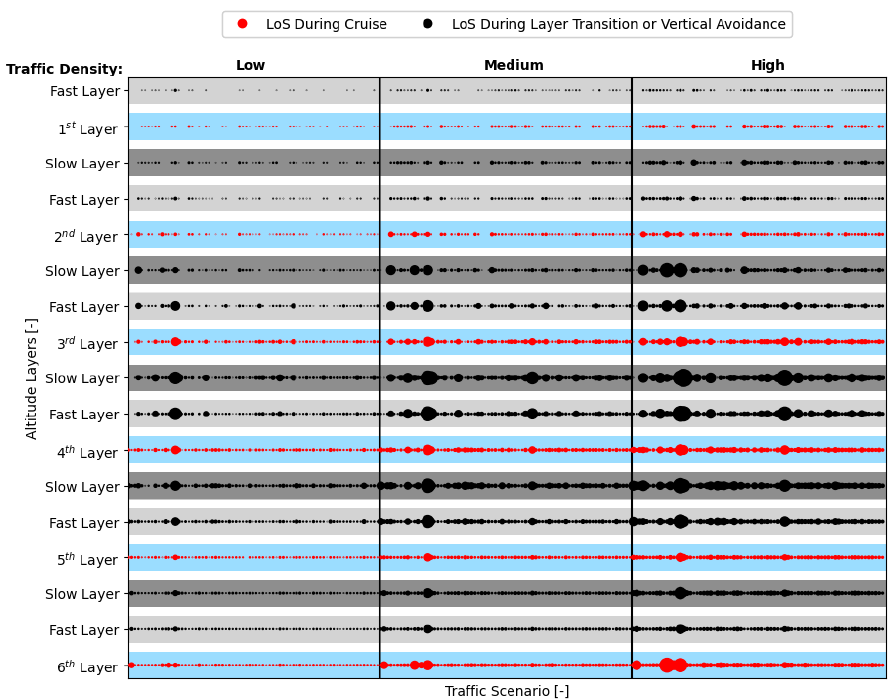
Figure 19. Altitudes at which LoSs occur with a baseline structure. The sizes of the points vary between a maximum value of 3128 and a minimum value of 1 LoS. All traffic densities have 75 traffic scenarios, with the initial direction(s) and the number of turns following the same order as shown during the training